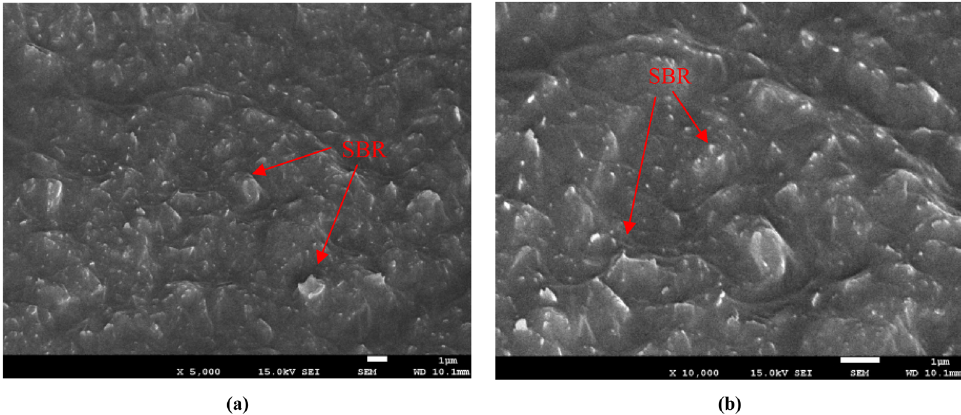
Figure 7: Di ff erent magni fi cation images of SBR - modi fi ed asphalt. ( a ) SBR - modi fi ed asphalt ampli fi es 5,000 times and ( b ) SBR - modi fi ed asphalt ampli fi es 10,000 times.